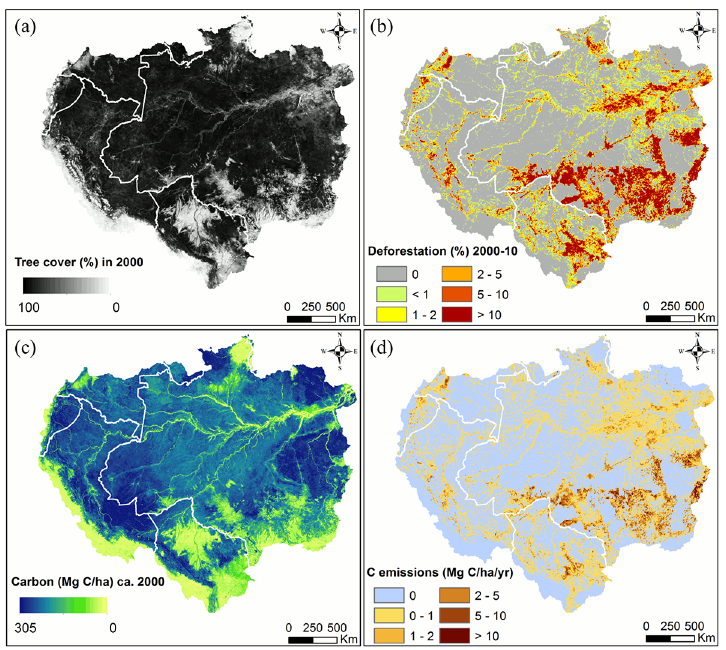
Fig 2. Maps of forest, deforestation, carbon stocks and carbon emissions in the Amazon basin. (a) Tree cover in year 2000 (b) Deforestation between 2000 and 2010 at 5 km spatial resolution. (c) Forest carbon density circa 2000. (d) Average C emission rate per unit deforestation at 5 km spatial resolution. White lines delineate country boundaries.